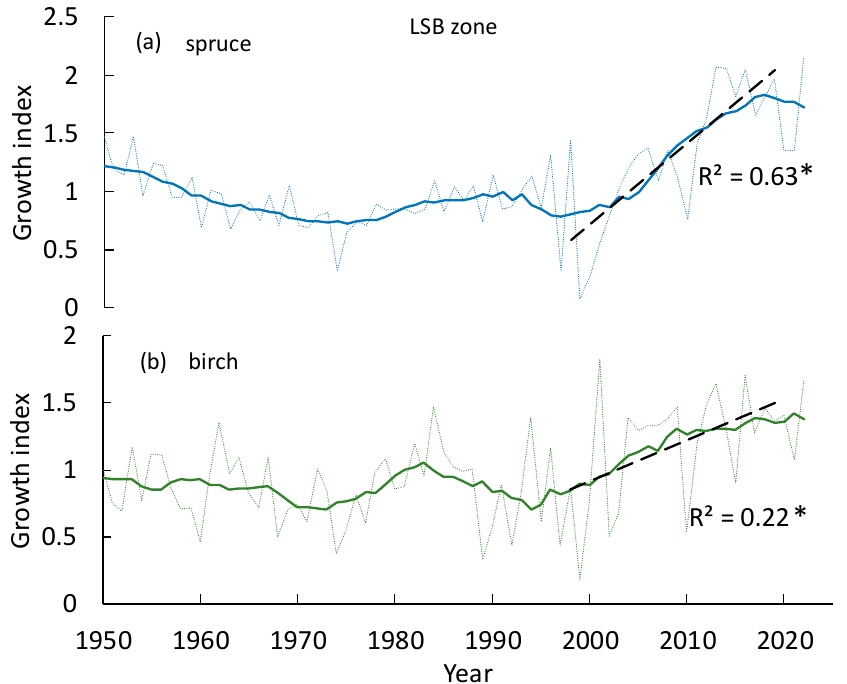
Figure 7. The LSB zone (brown dots in Figure 2). Comparative growth index dynamics of spruce and birch trees. Solid lines indicate an 11-year moving average. Stars (*) indicate significant trends at p < 0.05.